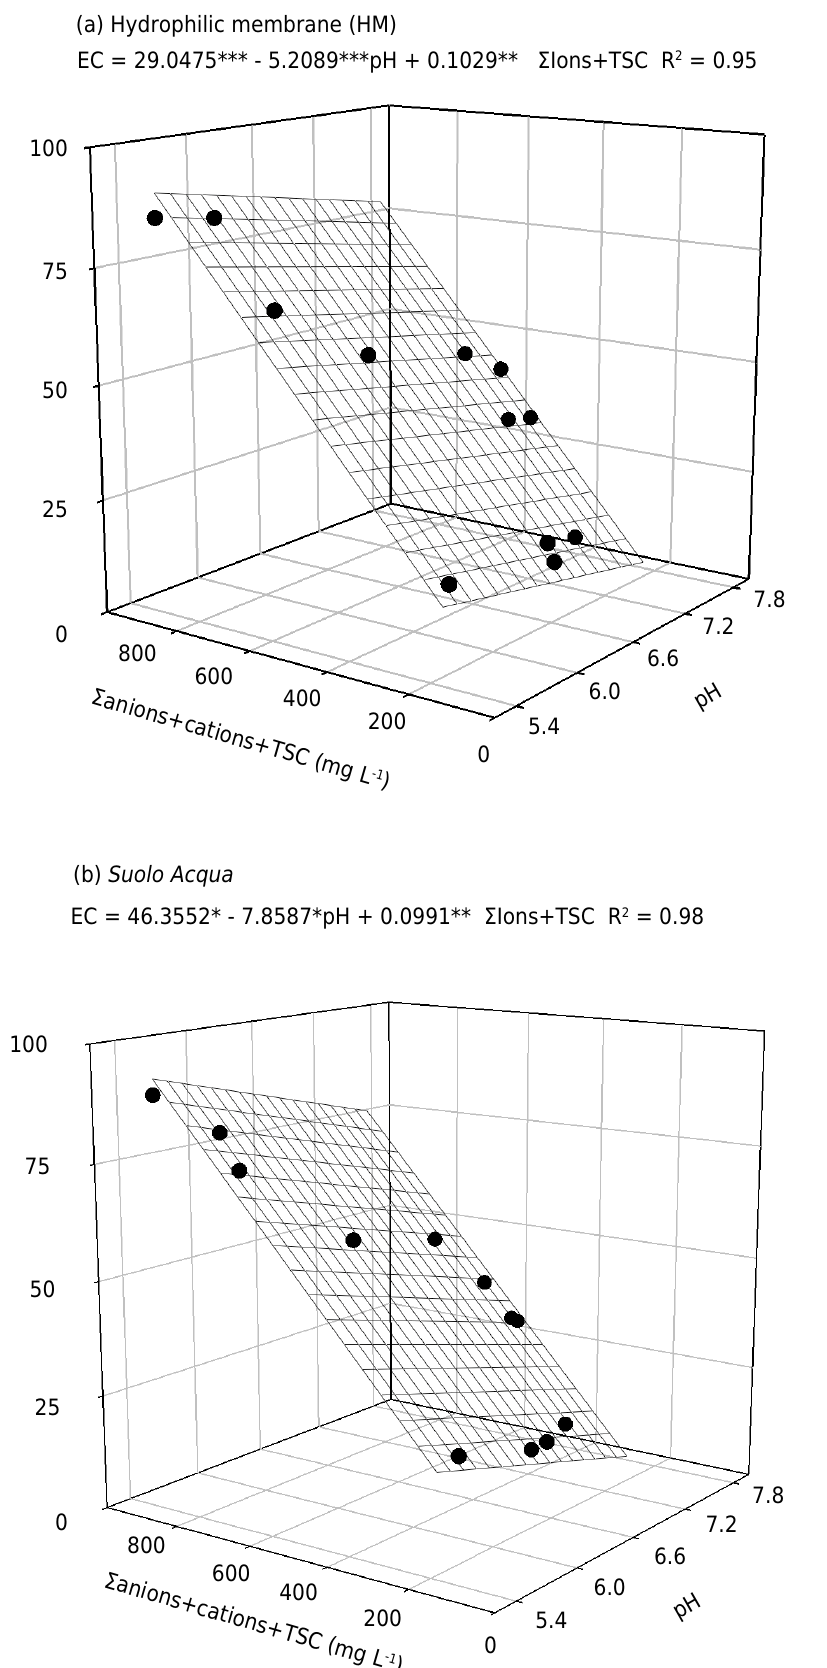
Figure 5. Solution electrical conductivity (EC) as a function of pH and Σ(anions+cations)+total soluble C (TSC), considering the data set of the three soils and four solution sampling times. (a) Hydrophilic membrane (HM) and (b) Suolo Acqua. Anions = F − , Cl − , NO − 3 , Br − , SO 4 2− ; and cations = Na + , NH + 4 , K + , Mg 2+ , Ca 2+ . *, **, and ***: significant at the 1, 5, and 10 %, respectively, by the F